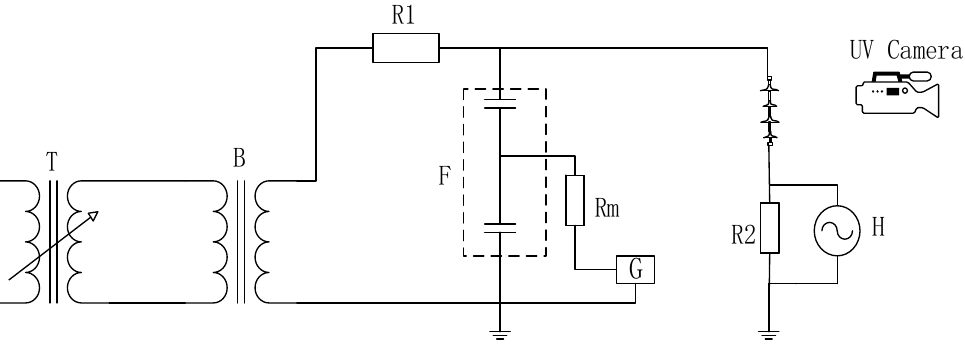
Figure 2. Schematic of the test circuit. T: 10 kV voltage regulator; B: testing AC transformer; R1, Rm: